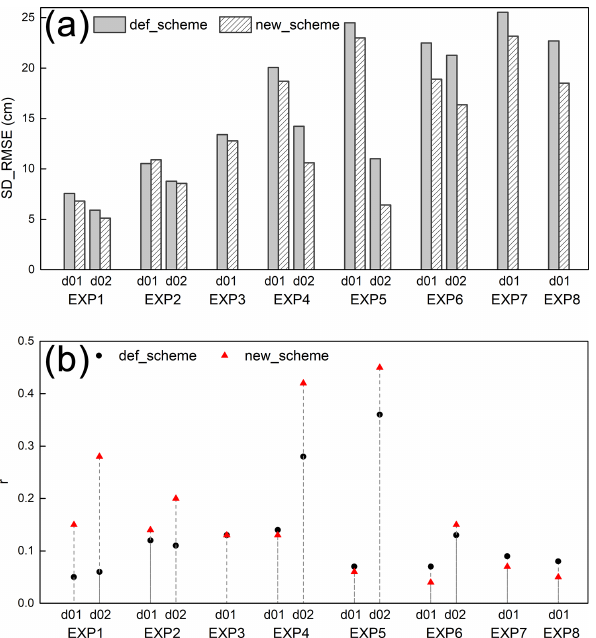
Figure 6. Same as Fig. 3 but for RMSE (a) and correlation coef- ficient (b) for snow depth (SD). The correlation coefficient is sig- nificant at the 0.01 significance level, except for d01 estimates in